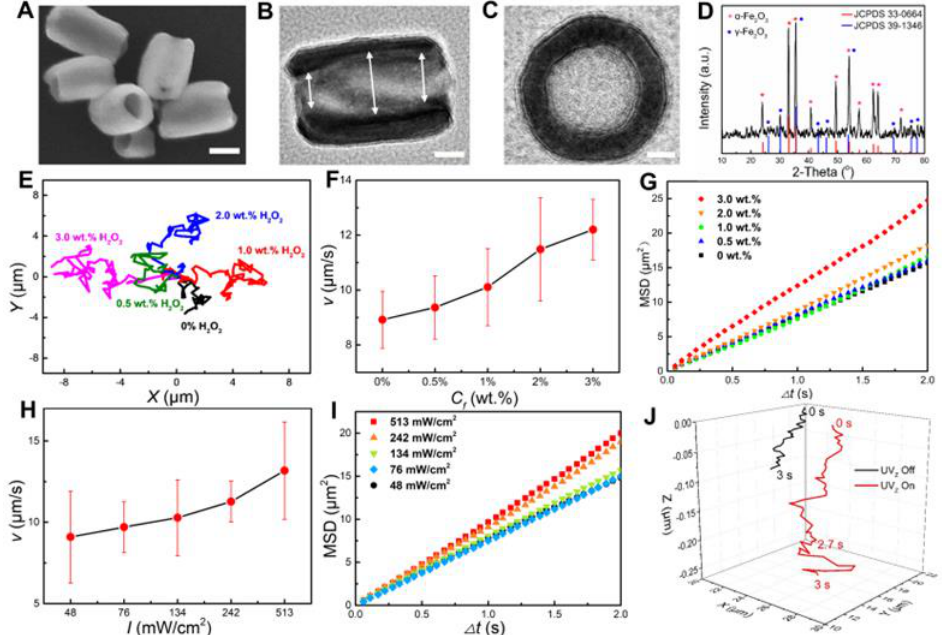
Figure 2. Structural characterization and motion behaviors of the Fe 2 O 3 TNMs. ( A ) SEM and ( B , C ) TEM images of the Fe 2 O 3 TNMs. Scale bars in ( A – C ) are 100 nm, 50 nm, and 25 nm, respectively. ( D ) XRD pattern of the Fe 2 O 3 TNMs. ( E ) Trajectories of the Fe 2 O 3 TNMs within 5 s under UV Z irradiation at different fuel concentration ( C f ). ( F ) Speed ( v ) of the Fe 2 O 3 TNMs as a function of C f . The light intensity ( I ) is kept at 513 mW/cm 2 . ( G ) Average MSD of the Fe 2 O 3 TNMs versus the time interval (Δ t ) at different C f . ( H ) The v of the nanomotors at different I . The C f is kept at 3.0 wt.%. ( I ) MSD as a function of Δ t at different I . ( J ) Three-dimensional trajectories of two typical Fe 2 O 3 TNMs when UV Z is on and off.